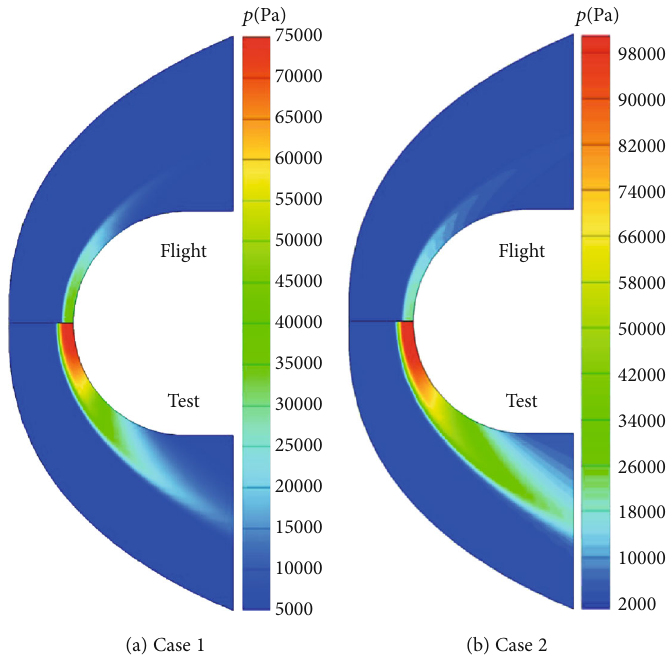
Figure 13: Comparison of the pressure on the symmetric plane.